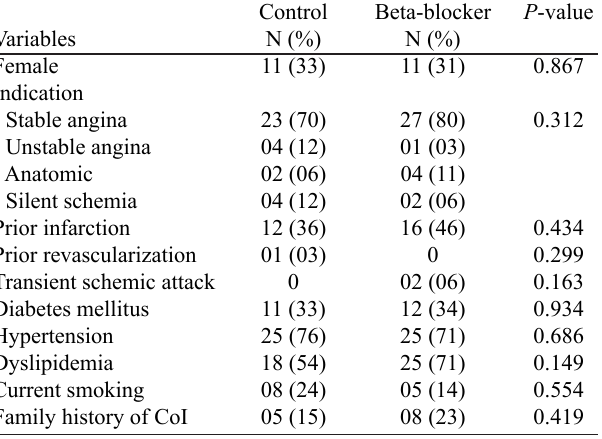
Table 1. Qualitative variables, comparison of the control and beta- blocker groups.